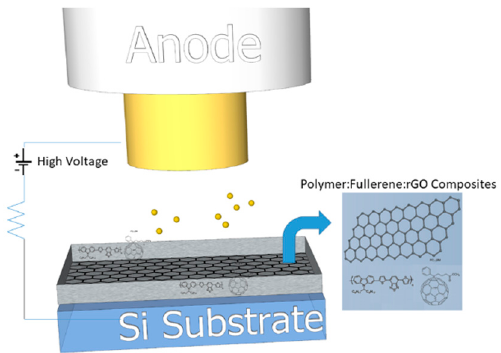
Figure 1. Schematic representation of a field emitter cathode based on hydroiodic acid (HI)-treated reduced graphene oxide (rGO)-charge transfer materials composites.